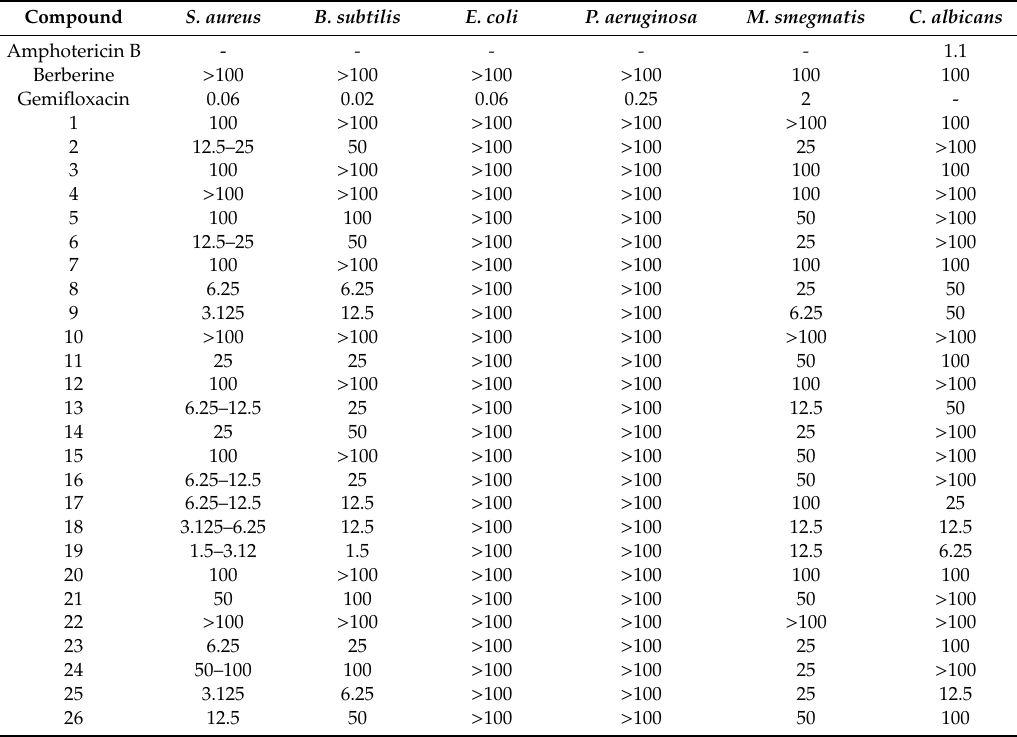
Table 1. Evaluation of the antimicrobial activity of the berberine derivatives. Antibacterial and antifungal activities of the berberine’s derivatives were tested using selected representing strains of Gram-positive, Gram-negative, Mycobacterium and fungi as explained in the Materials and Methods Section. Values in the table correspond to Minimal Inhibitory Concentration (MIC) expressed in µ M. Berberine was used as reference molecule.